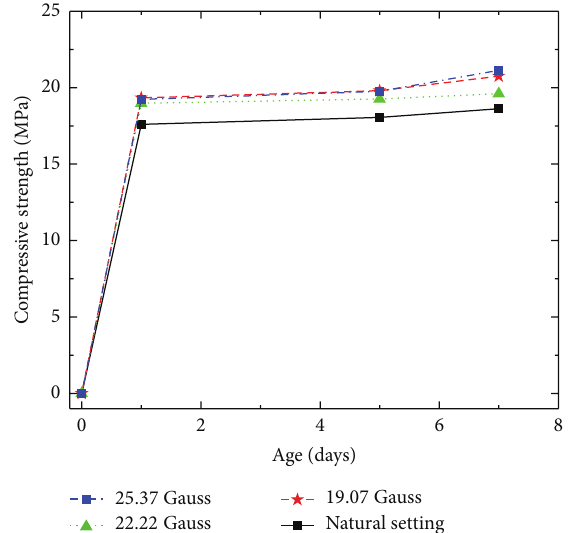
Figure 4: Setting times for the cement pastes. Figure 5: Compressive strength of cement pastes for each magnetic induction